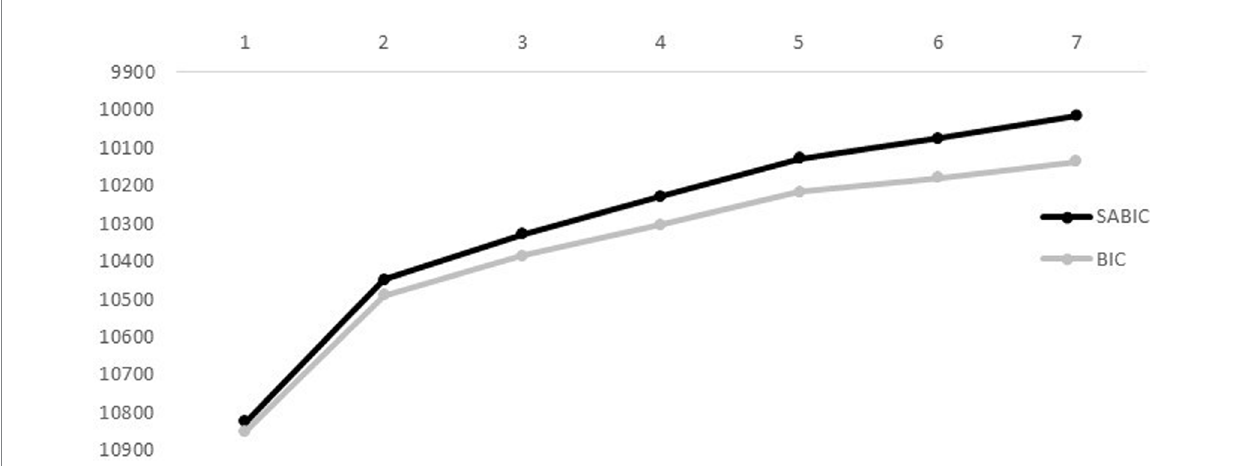
FIGURE 1 Elbow plot for the Bayesian information criterion (BIC) and the sample-size adjusted Bayesian information criterion (SABIC) for the seven tested profile